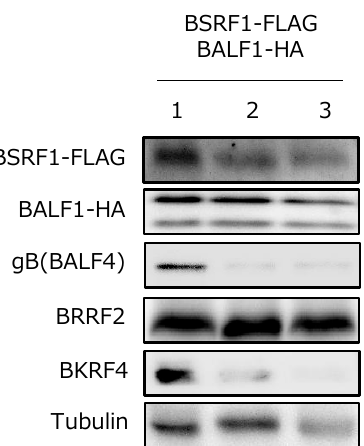
Figure 7. Incorporation of BSRF1 and BALF1 in virions. EBV particles were prepared from B95-8 cell culture medium and transfected with the indicated expression vectors. The medium was precleared via low-speed centrifugation and filtration. Virions were collected by ultracentrifugation in the absence (lane 1) or presence of NP-40 (lane 2) or NP-40 plus 300 mM NaCl (lane 3), followed by immunoblotting with the indicated